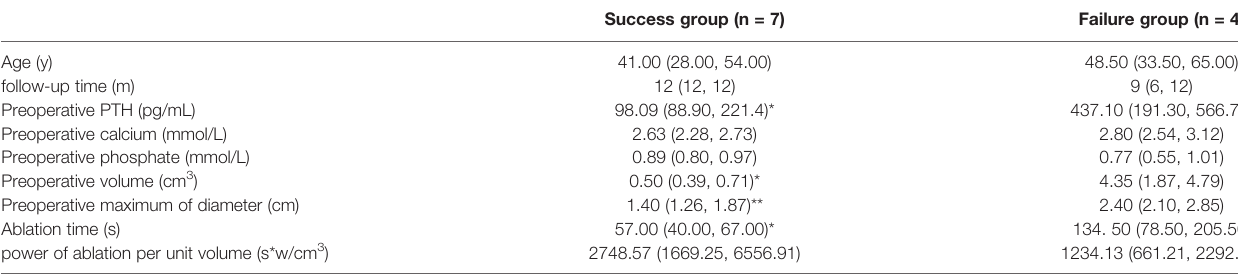
TABLE 5 | Comparisons between success group and failure group.